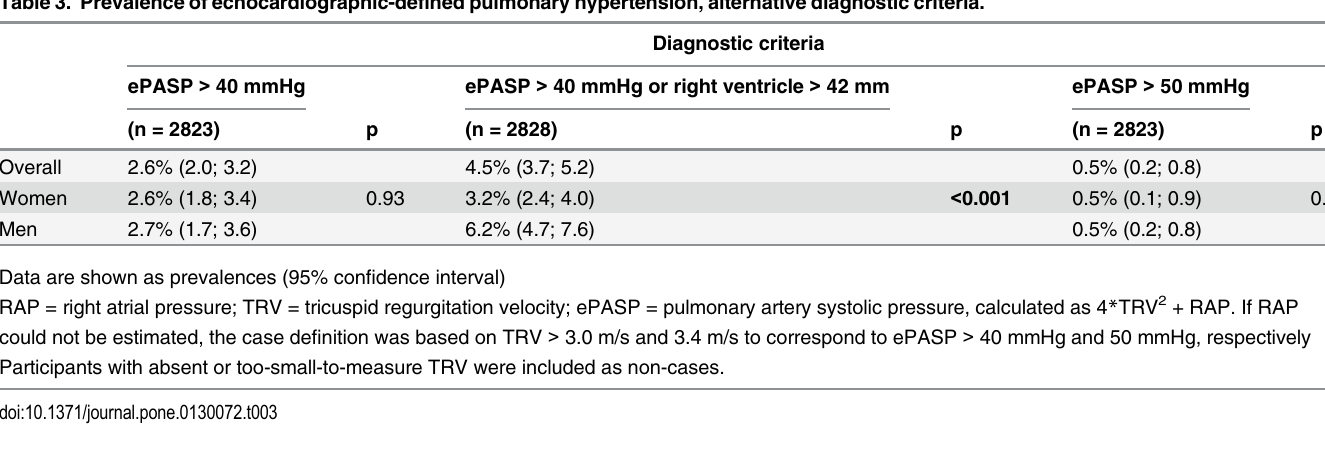
Table 3. Prevalence of echocardiographic-defined pulmonary hypertension, alternative diagnostic criteria.